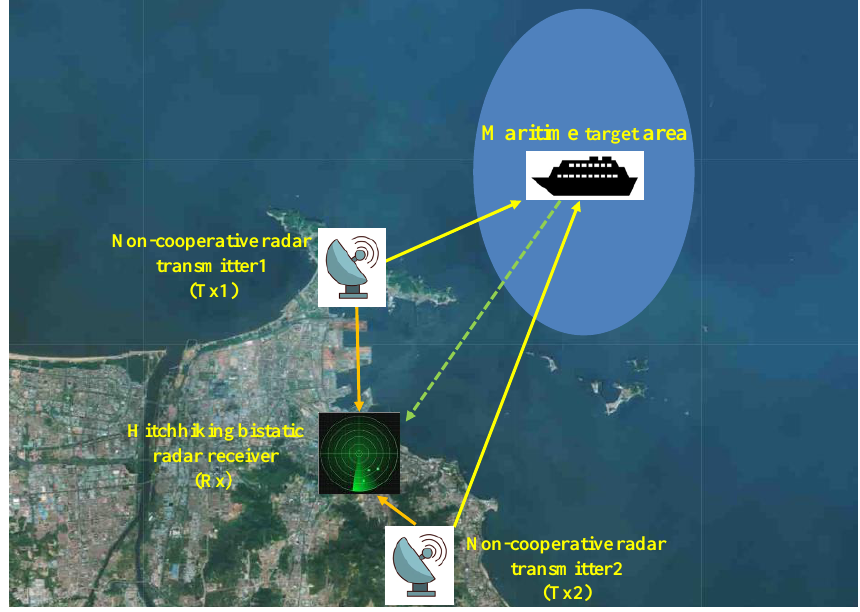
Figure 7. Scenario of the field